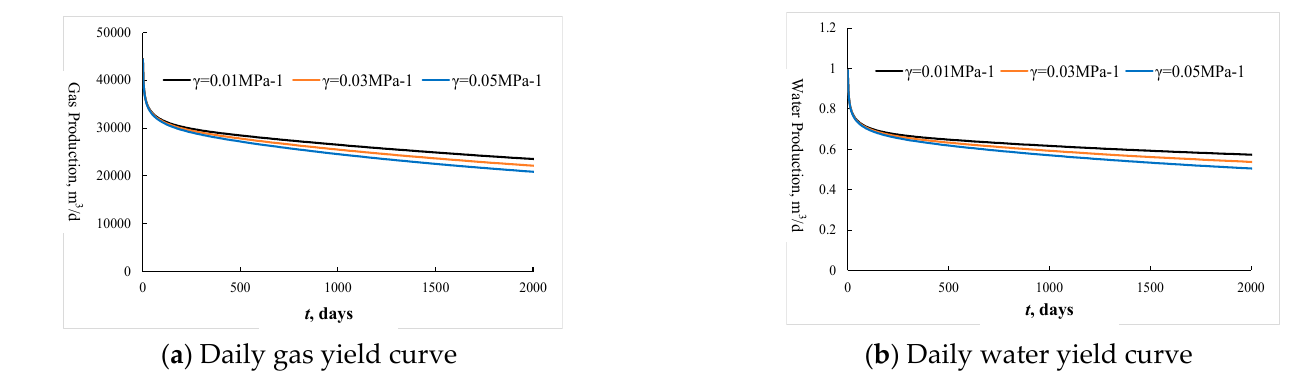
Figure 6. Effects of the stress sensitivity of the fracture on the gas and water production rates.